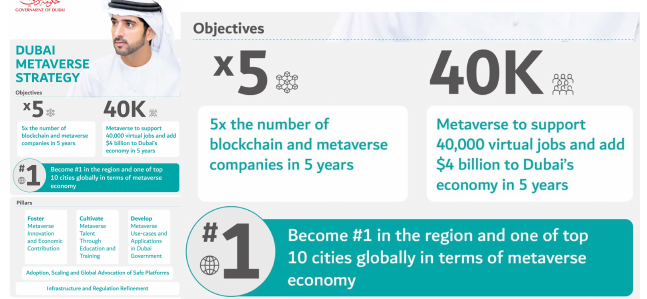
Figure 11: Dubai’s Metaverse Strategy